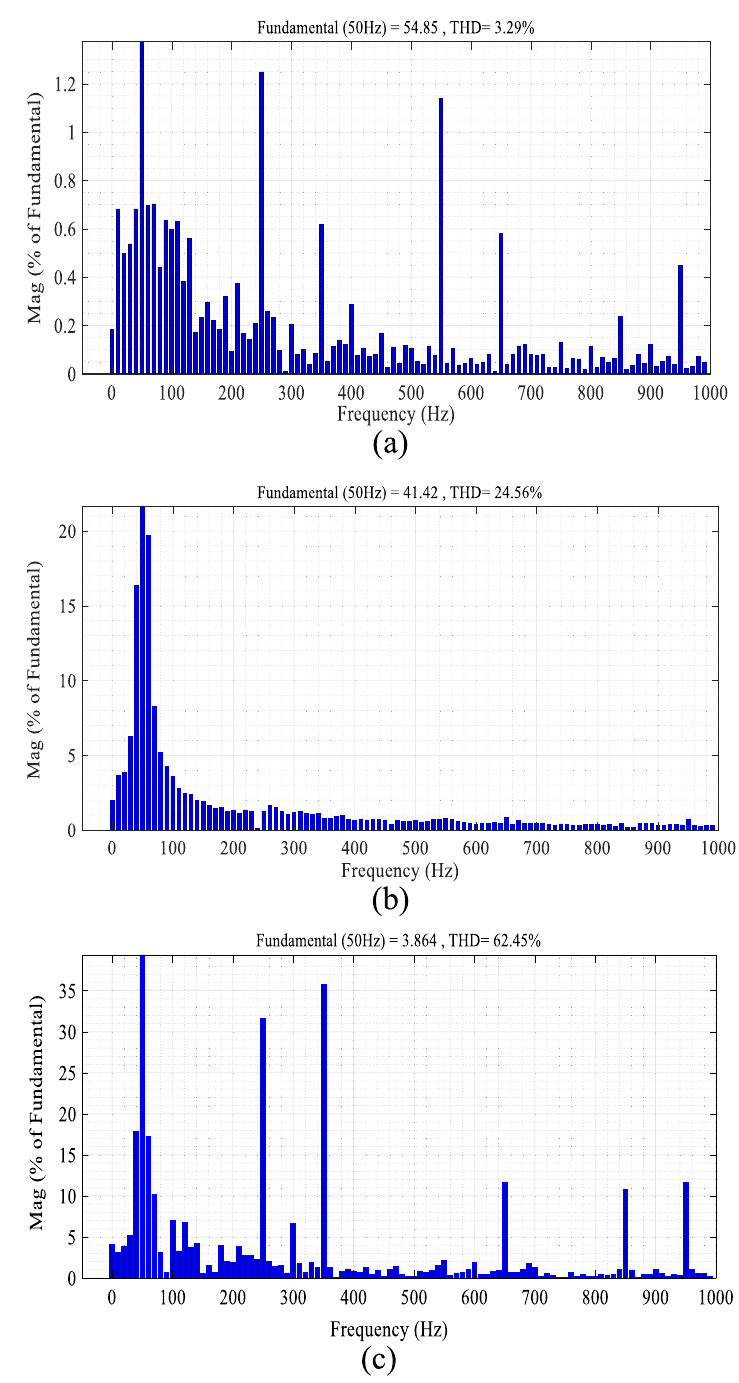
Fig. 17 Spectrum analysis of PV current in the cases of a FL-MPPT, b NNT-MPPT, and c